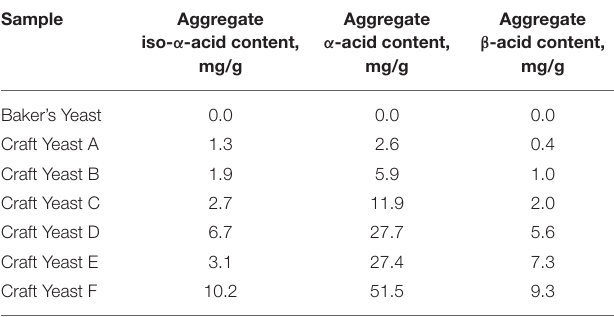
TABLE 1 | Hop-derived content found in spent yeast from six ale-style beers a .